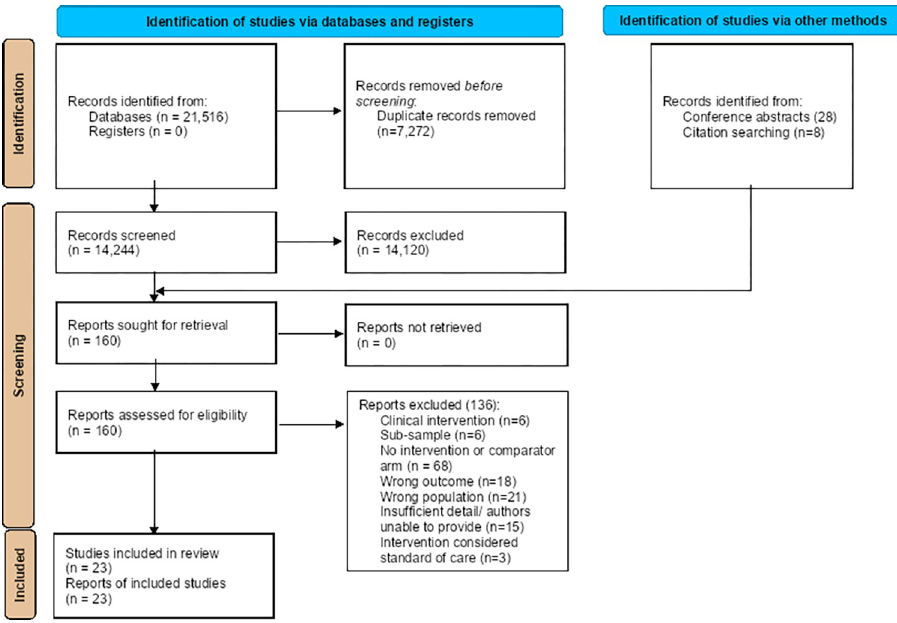
Fig 1. PRISMA study selection flow chart. PRISMA = Preferred Reporting Items for Systematic Reviews and Meta- Analyses.